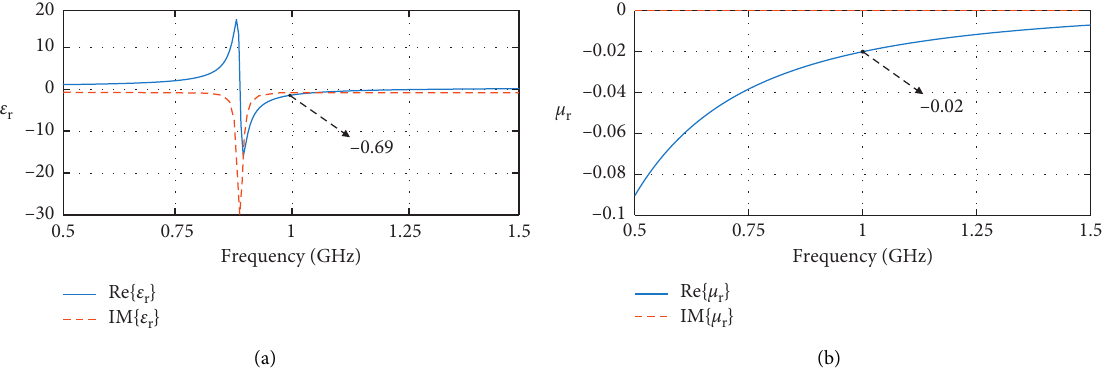
Figure 5: The effective relative permittivity (a) and permeability (b) of the loaded transmission line.